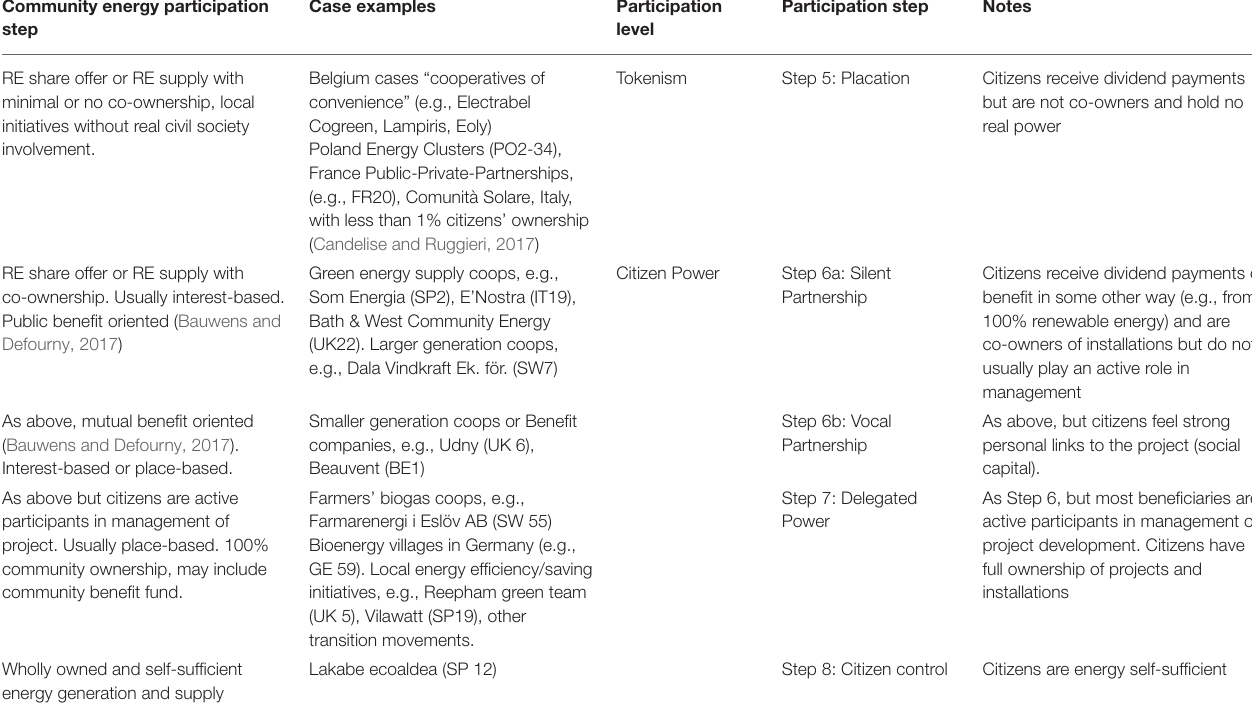
TABLE 4 | Different levels of participation in CE initiatives in